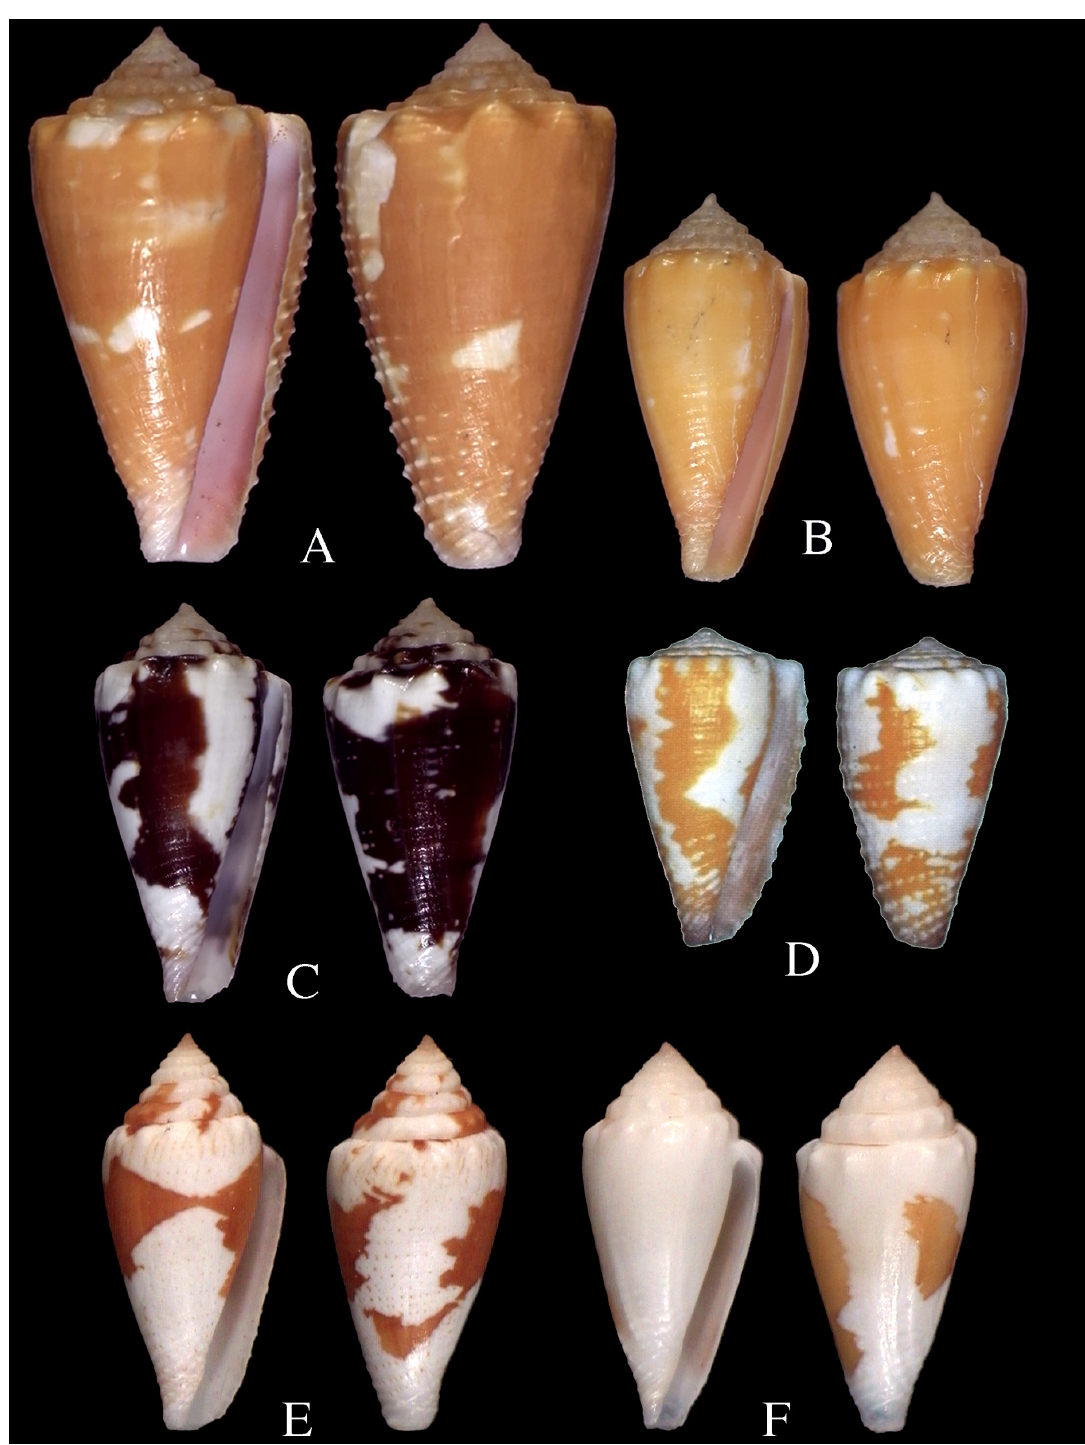
Fig. 6. A . Conus exiguus var. optimus Sowerby, 1913, 35.3 mm. Point Parme, New Caledonia. FL. B . Conus exiguus var. bougei Sowerby, 1907, 20.3 mm. Poum, N. New Caledonia. FL. C . Conus exiguus var. cabritii Bernardi, 1858, 22.0 mm. Northern New Caledonia. FL. D . Conus sp. cf. exiguus , 18.0 mm. Apia, Western Samoa. From Röckel et al. (1995), pl. 72, figs 14–15. E–F . Conus hanshassi (Lorenz & Barbier, 2012). E . 23.4 mm. Siargao Is., Philippines. Holotype, MNHN-IM-2000-24814. F . 22.9 mm. Siargao Is., Philippines. Paratype 1,